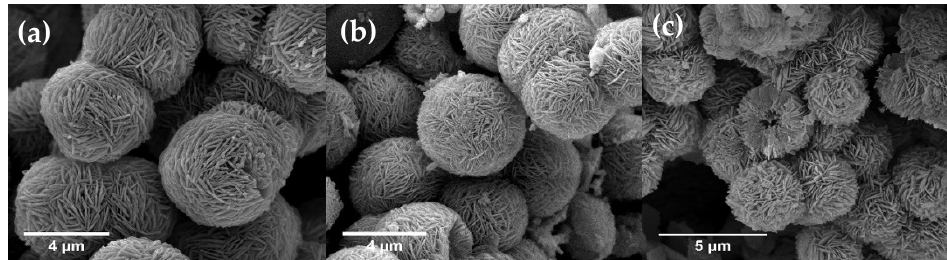
Figure 8. SEM images of ZnO@MOF-46(Zn) sonicated for 10 ( a ), 20 ( b ), and 30 min ( c ).